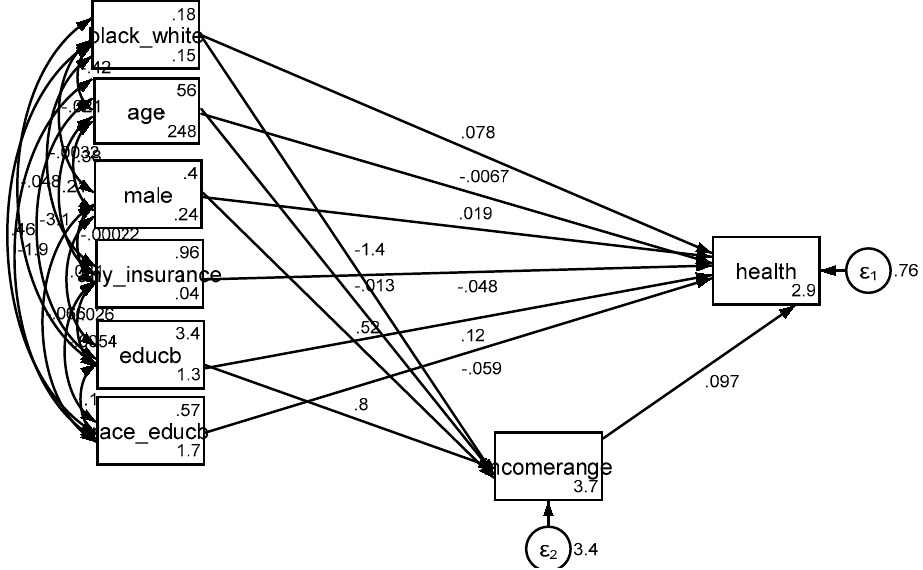
Figure 3. Summary of the results of Model 3 (income as a mediator).